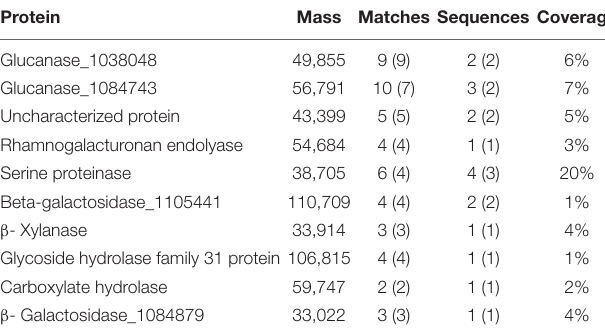
TABLE 2 | Partial secreted proteins of fusant D1-P*. Protein